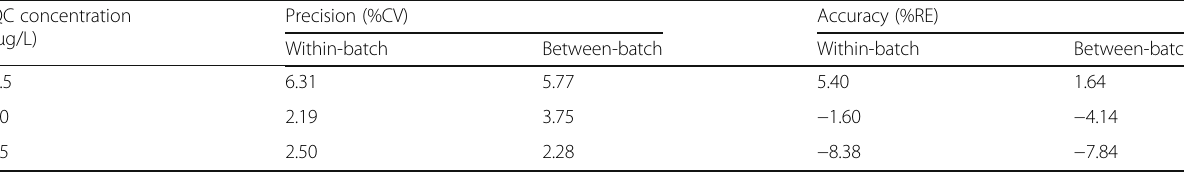
CV Coefficient of variation, RE Relative